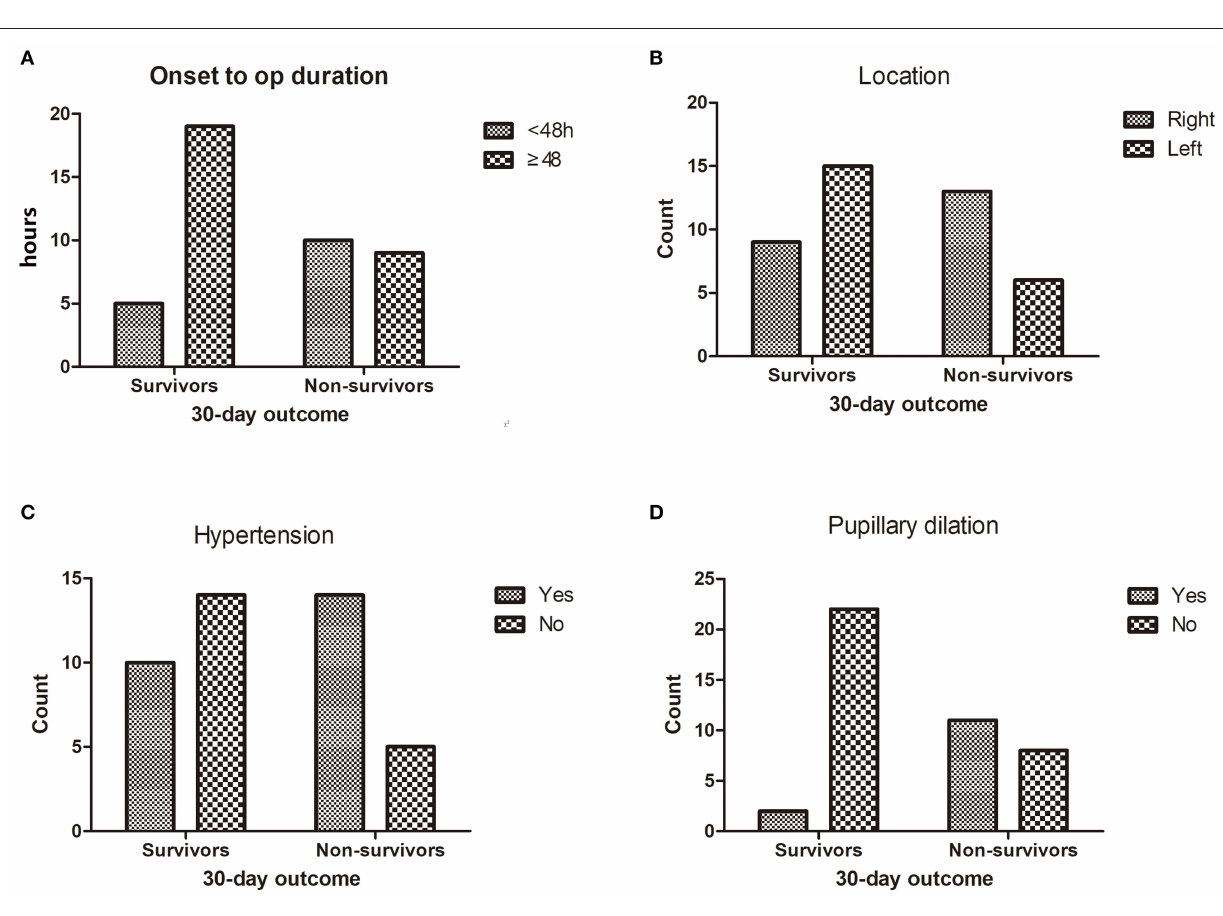
FIGURE 2 | The difference between survivors and non-survivors for enumeration data (30-day outcome).The distribution of onset to op duration (A) , location (B) , hypertension (C) and pupillary dilation (D) between survivors and